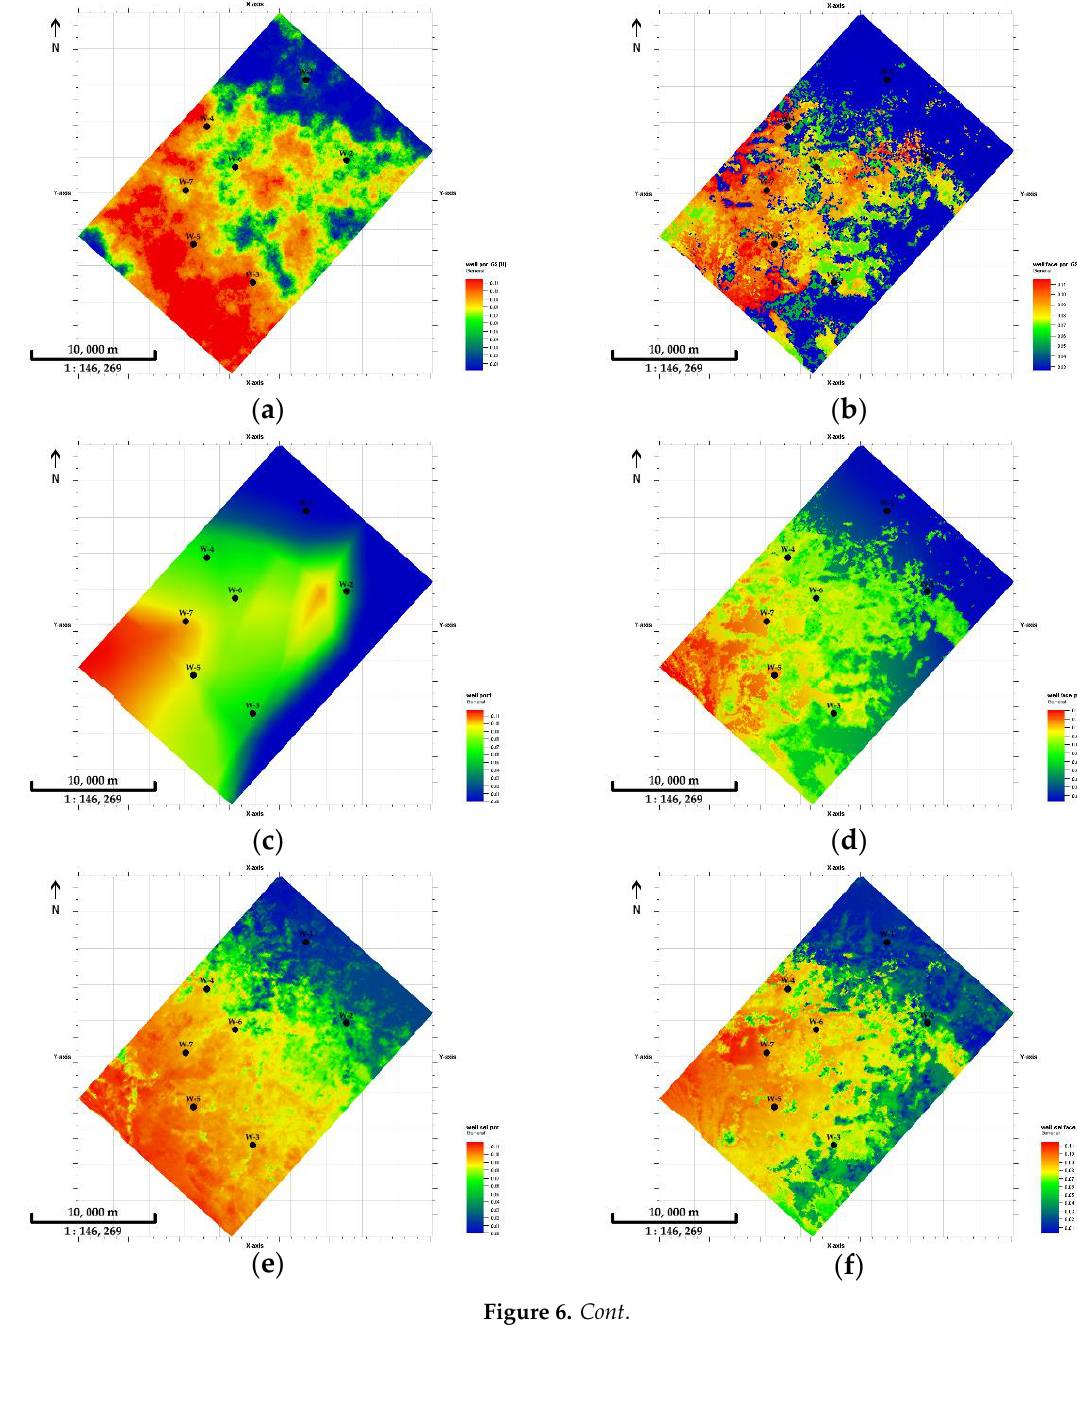
( h ) Figure 6. Porosity model of the X area in Karamay, Xinjiang, China: ( a ) porosity model simulated by the conventional sequential Gaussian simulation method; ( b ) porosity model simulated by the facies- controlled conventional sequential Gaussian simulation method; ( c ) porosity model simulated by the DFNN-based reservoir geological modeling method; ( d ) porosity model simulated by the DFNN- based facies-controlled reservoir geological modeling method; ( e ) porosity model simulated by the DFNN-based non-facies-controlled well-seismic combined reservoir geological modeling method; ( f ) porosity model simulated by the DFNN-based facies-controlled well-seismic combined reservoir